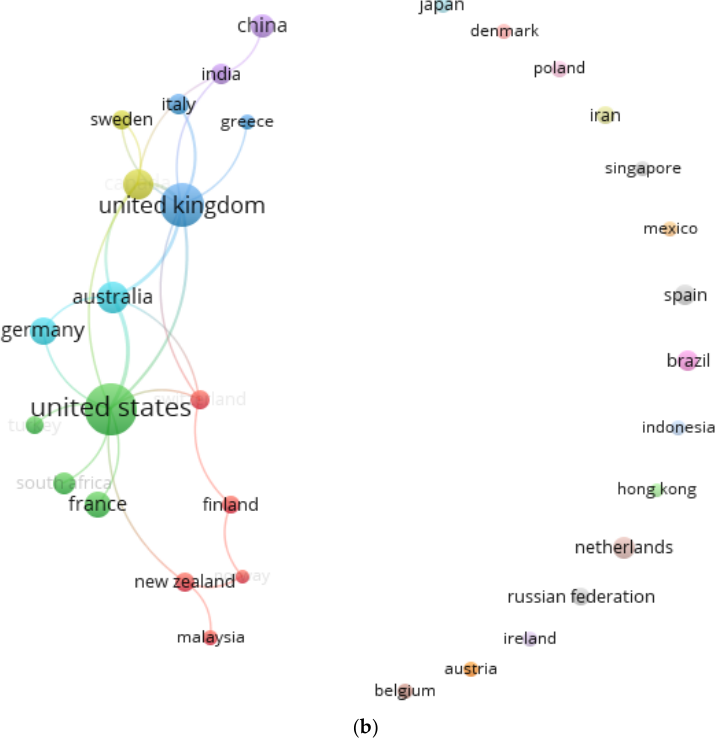
Figure 4. Citation analysis by ( a ) document and ( b )